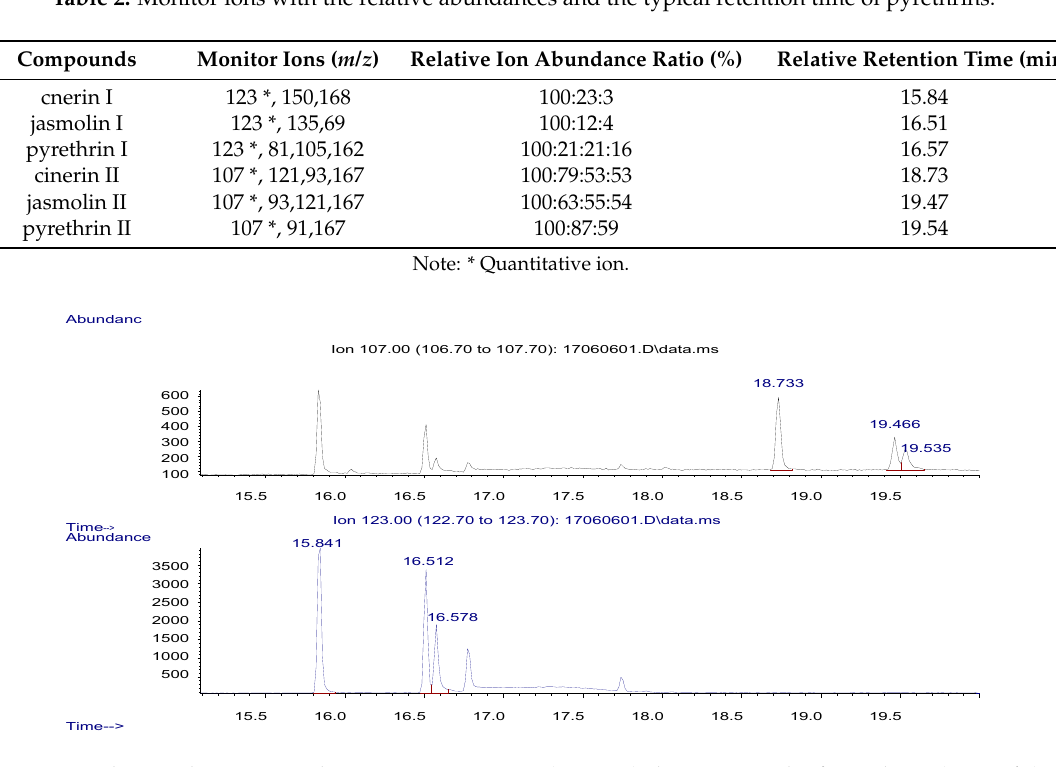
Figure 2. The gas chromatography–mass spectrometry (GC–MS) chromatograph of pyrethrins (10 mg/L).